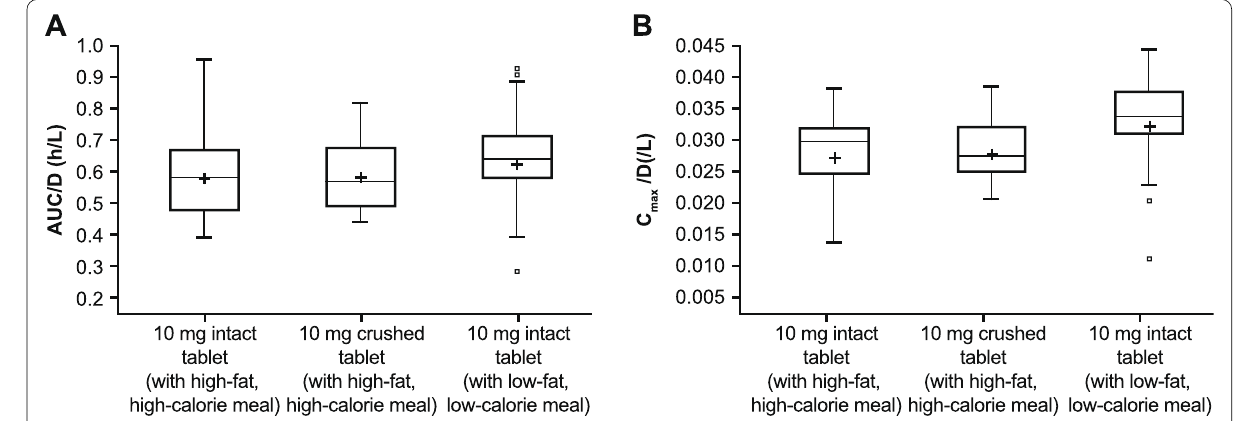
Fig. 4 Effects of crushing tablets: box plots for A AUC/D (h/L) and B C max /D (/L) of vericiguat in plasma following a single oral dose administration of vericiguat 10 mg as intact tablets or as a crushed tablet suspension. Box plots represent the 25th to 75th percentiles; bold horizontal lines represent the median values. n 29 for each treatment. AUC/D , dose-normalized area under the curve; Cmax/D , dose-normalized maximum plasma =